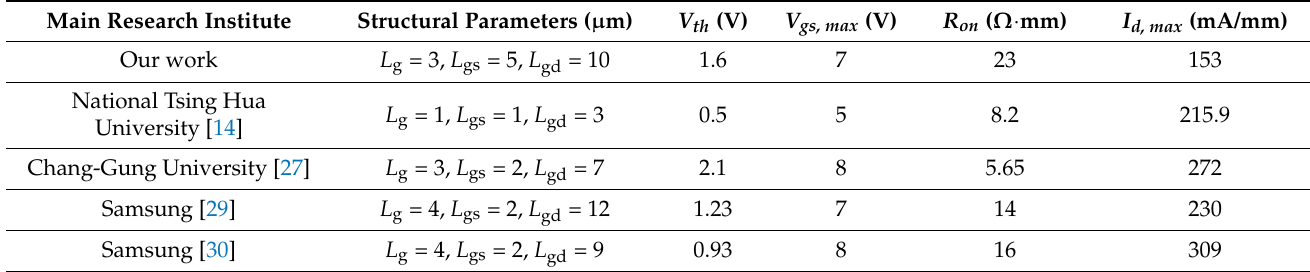
Figure 7. ( a ) Transfer characteristic curves, ( b ) I gs – V gs curves, ( c ) output characteristics of the p-GaN HEMT device. Table 1. Summary and comparison of the performance of the traditional p-GaN high-electron-mobility transistors (HEMTs).